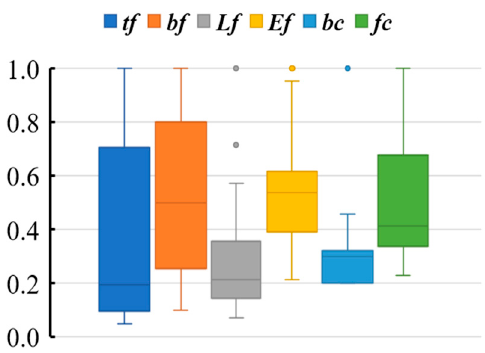
Figure 3. Variability ranges of the input-parameters by means the box plot representation. Table 2. Interquartile ranges of the input parameters.